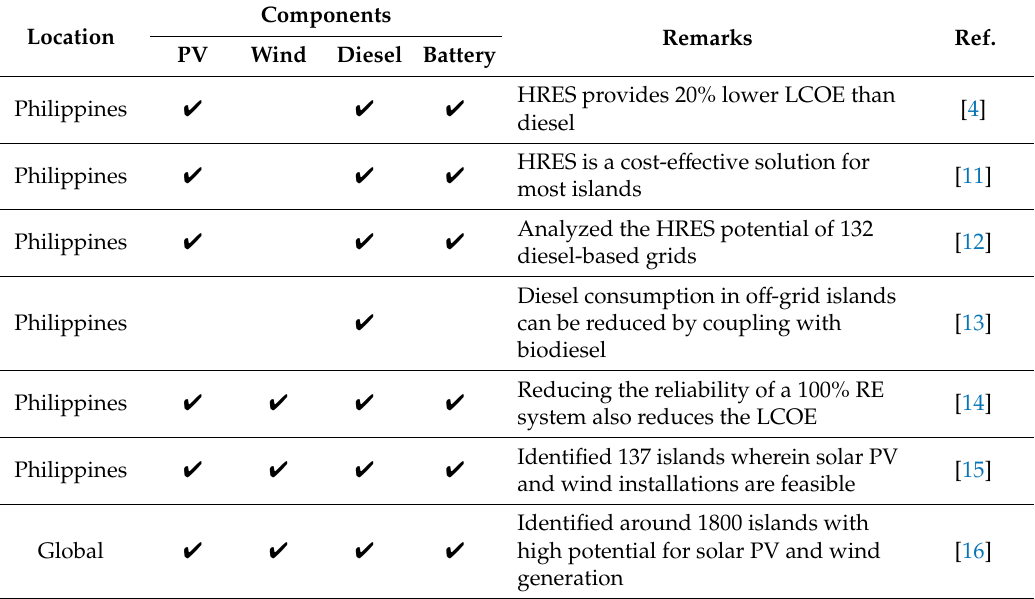
Table 1. Summary of studies in hybrid renewable energy systems (HRESs) in o ff -grid islands.